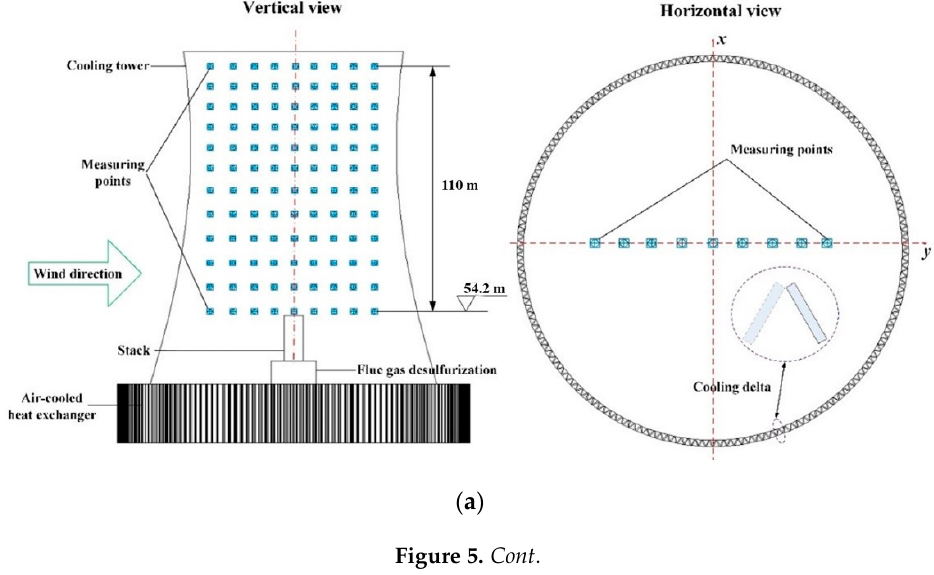
Figure 4. Detailed geometries and local meshes of the key sections in the numerical model of NDDCS with one tower. ( a ) Geometries; ( b ) local